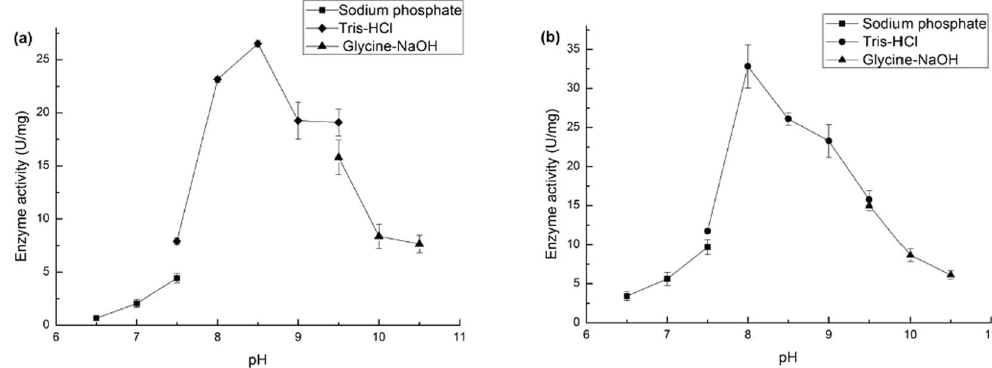
Figure 2. Characterization of the purified recombinant KpnAspDH and DelAspDH. ( a ) The optimal pH of KpnAspDH determined in various buffers from pH 6.5 to 10.5; the buffers used were glycine-NaOH (9.5–10.5) (black triangle), Tris-HCl (7.5–9.5) (black circle), Na 2 HPO 4 –NaH 2 PO 4 (6.5–7.5) (black square). ( b ) The optimal pH of DelAspDH determined in the same buffer as above.